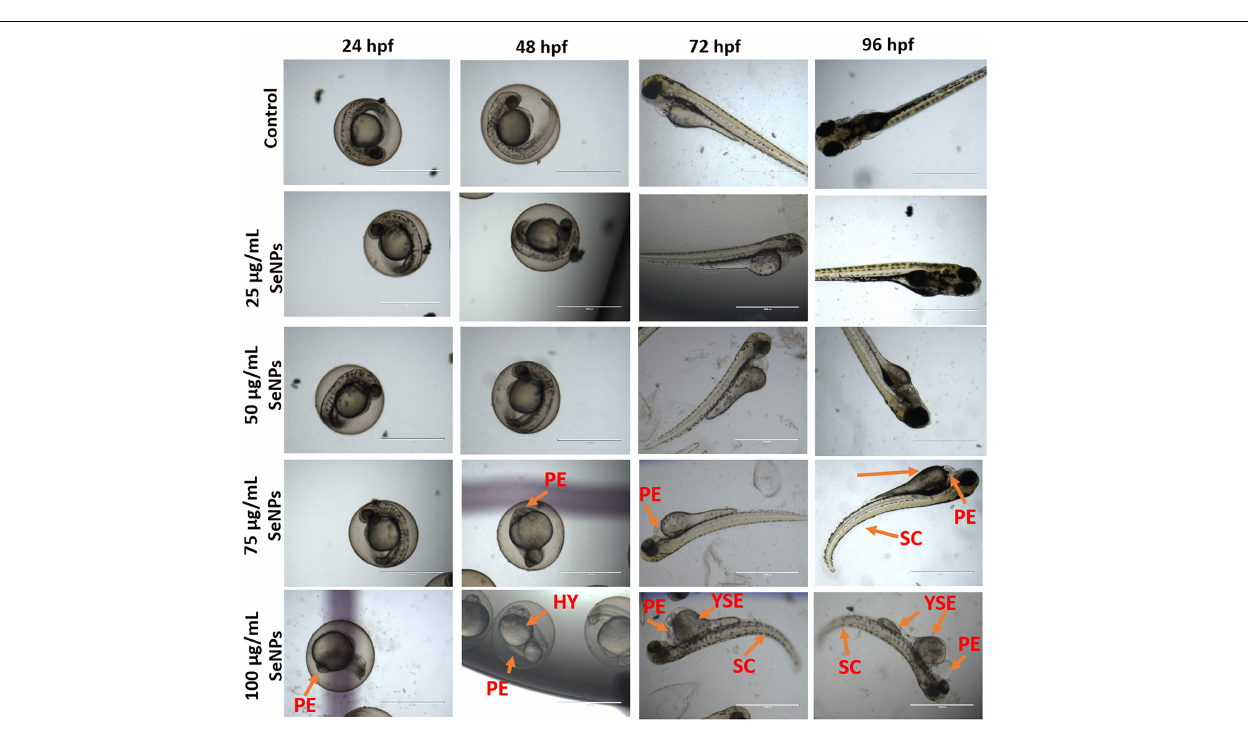
FIGURE 14 | Dose-dependent toxic effect of SeNPs on embryogenesis of D. rerio at 24, 48, 72, and 96 hpf. PE, pericardial edema; HY, hyperemia; SC, spinal curvature; YSE, yolk sac edema. The images were captured at a magnification of × 4. Scale bar = 1,000 µ